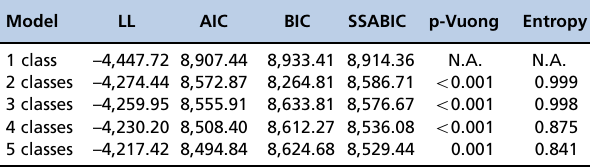
Table 2 - Comparison of the fit statistics according to the number of latent classes for the outcome ‘ initiation of positive pressure ventilation ’ among the 560 questionnaire respondents.